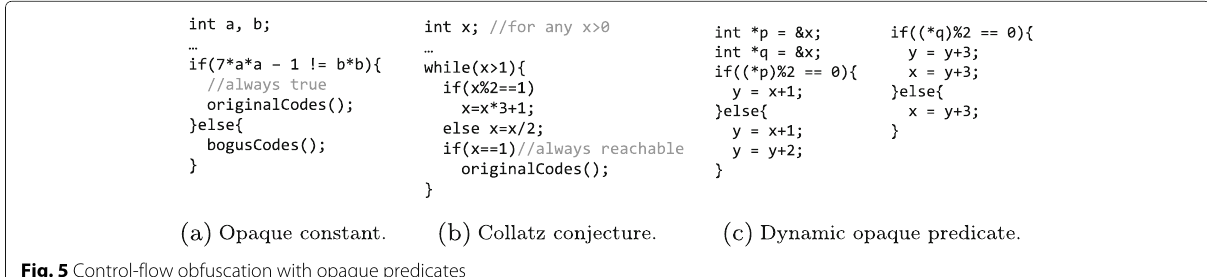
Fig. 5 Control-flow obfuscation with opaque